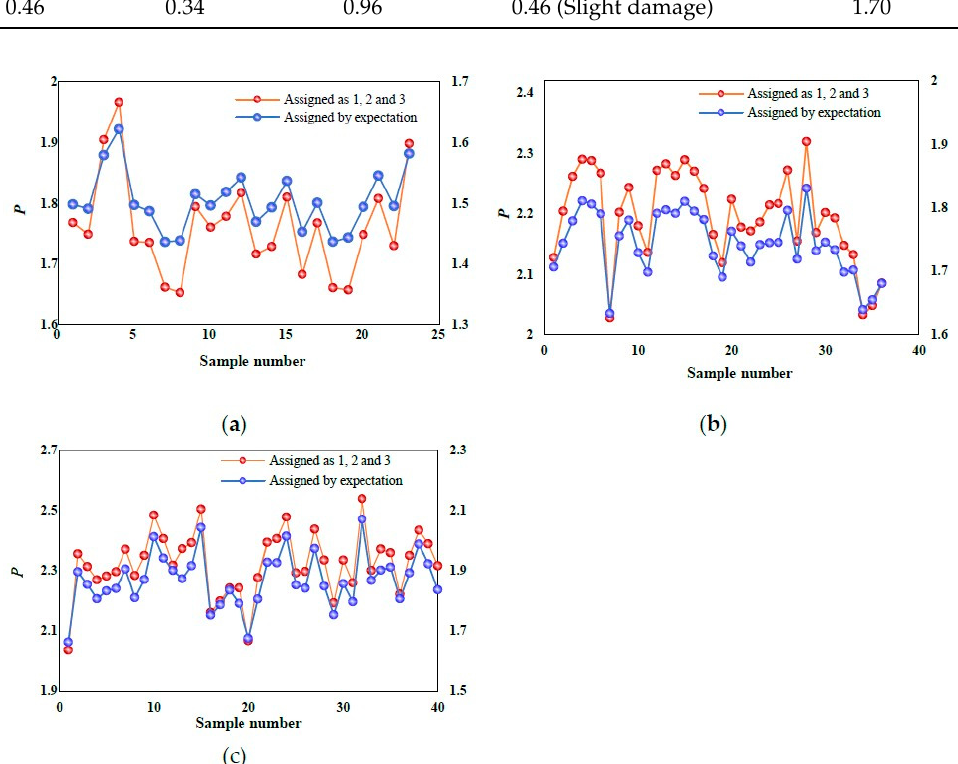
Figure 11. Comprehensive evaluation results by using the two assignment methods for eigenvalues of each damage level. ( a ) No damage; ( b ) slight damage; ( c ) moderate damage. Comparing the known damage levels of 100 data samples to the predicted damage levels, it was found that the accuracy rate of damage level determined based on the prin- ciple of maximum affiliation was 81.1% (Table 9). The accuracy rate of slight damage was the lowest, with 13 of 44 sample data misclassified as moderate damage, which lead to a lower accuracy rate of the model. It is worth noting that, for the majority of samples that were misclassified, the comprehensive membership degrees of the correct damage level and the chosen damage level were very close. For example, sample data No. 7 was iden- tified as slight damage level in the mine but was classified as moderate damage. In the comprehensive membership, degrees of the slight damage and moderate damage were 0.39 and 0.40. According to the maximum membership rule, the evaluation result of this sample data is moderate damage. However, the comprehensive evaluation value p of this sample is 1.75, which is very close to the mean value of slight damage samples, P — Slight =